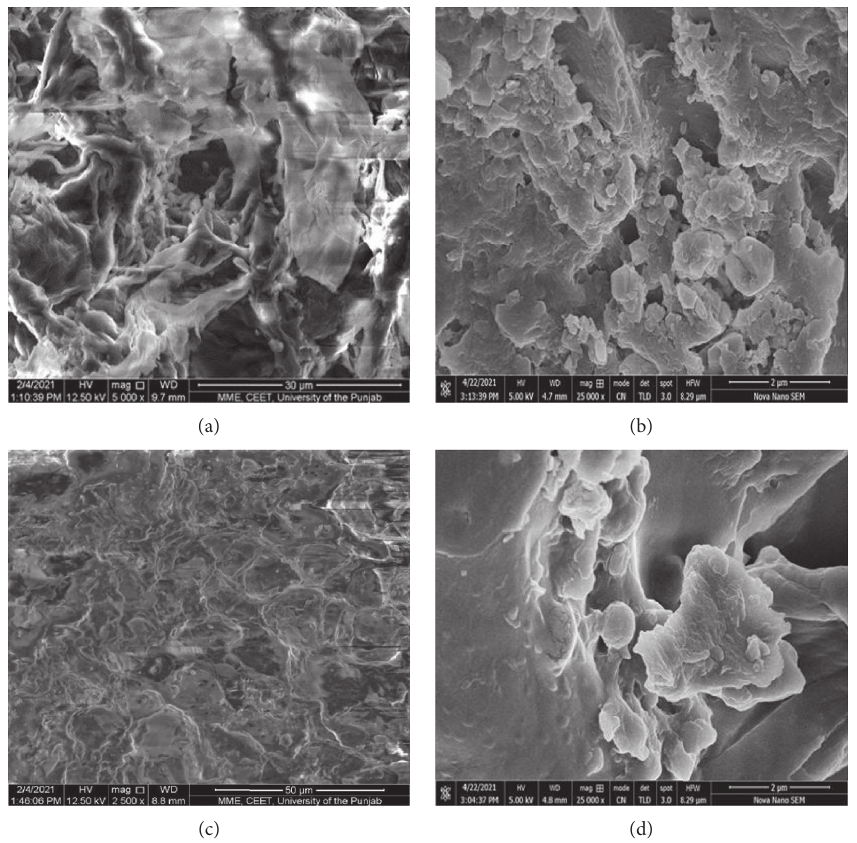
Figure 6: SEM of (a) R-TNP, (b) CA-TNP, (c) CLP, and (d) CA-CLP.